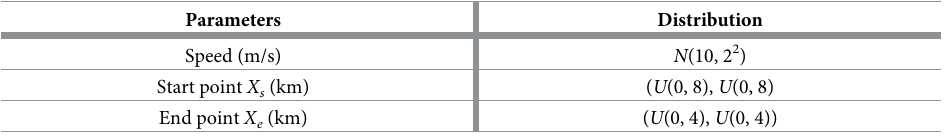
Table 6. Parameters of the jammer